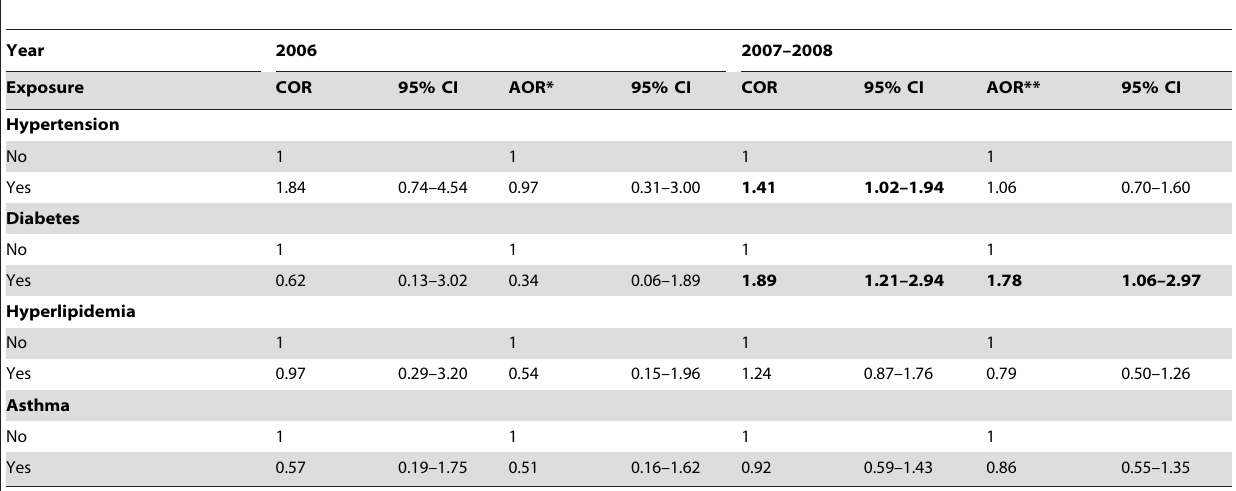
Table 3. Crude and adjusted odds ratios of the association of DHF with co-morbidities in year 2006 and year 2007–2008 epidemics.